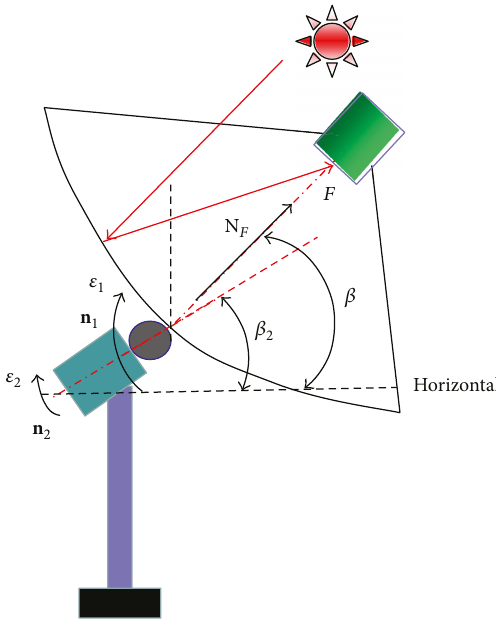
Figure 12: A schematic diagram of the spin-elevation double-axis tracking in dish concentrator system.